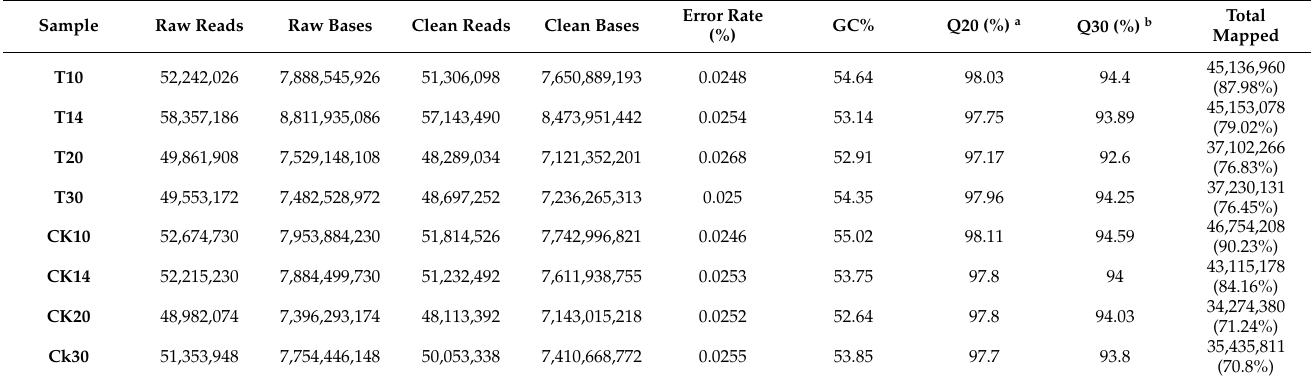
Table 2. Summary of sequencing outcomes from grain enlargement